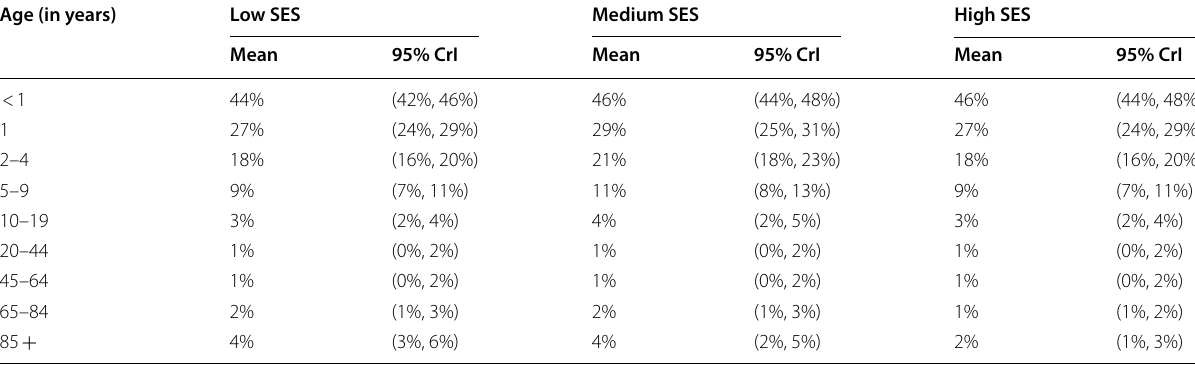
Table 1 Estimated Percentage of Respiratory Hospitalizations Attributable to RSV infections, by SES and Age Group, 2005–2014 Age (in